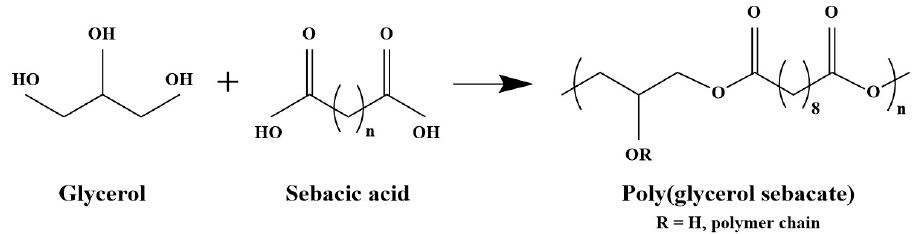
Figure 1. Poly(glycerol sebacate) obtained by polycondensation of glycerol and sebacic